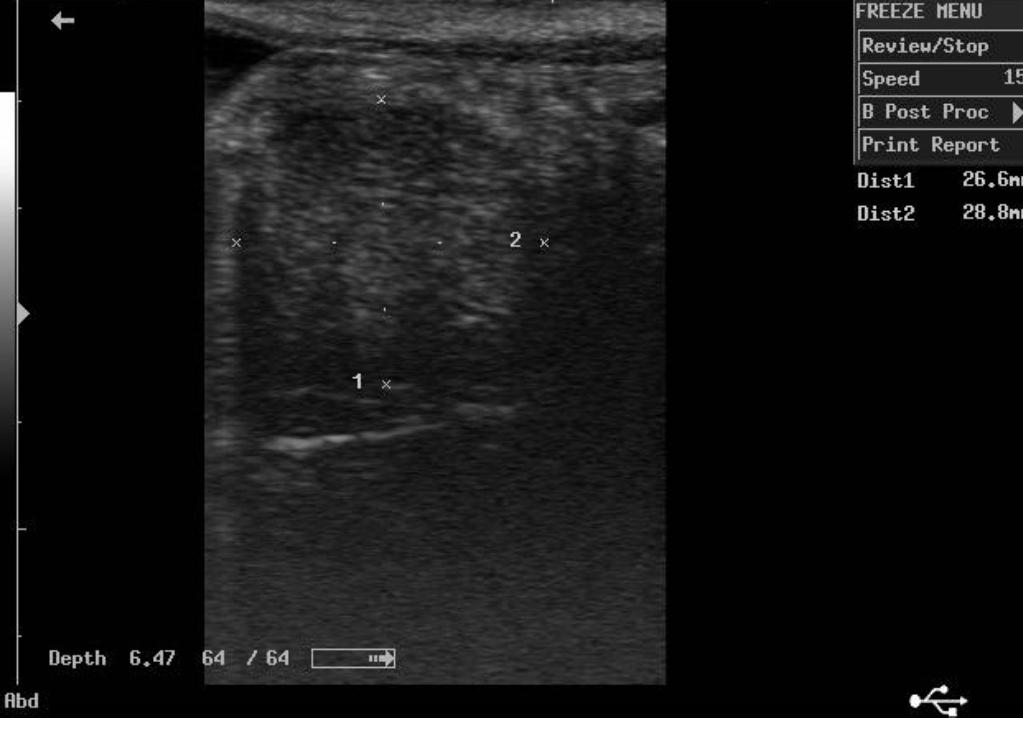
Figure 4. Ultrasound image of the middle tract of the non-post-pregnant uterine horn, at day 14 postpartum.